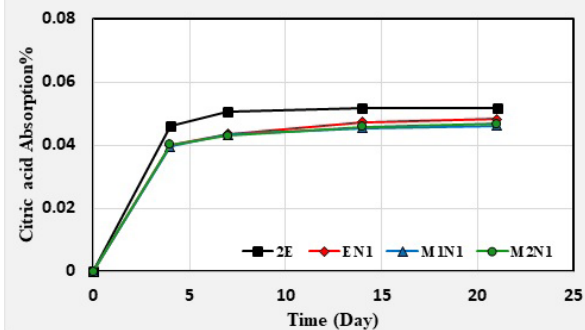
O particles when immersed in citric 2 3